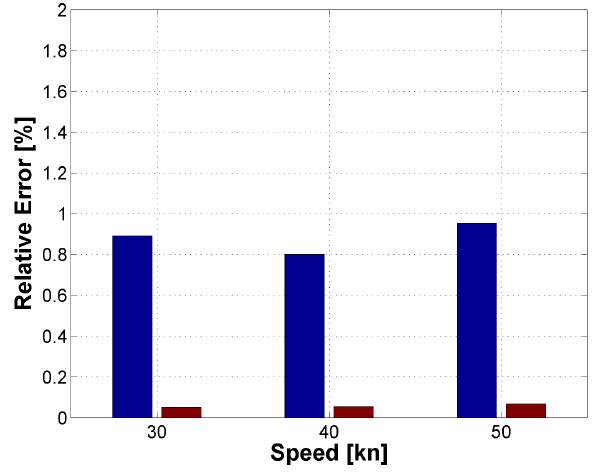
Figure 26: Average relative error for simulations at various, glide- slope angles and helicopter weights, with the measurement ar- ray augmented with air density and helicopter weight. Observer checked on the same samples considered for identification. Left bars: TPP-AOA, right bars: thrust